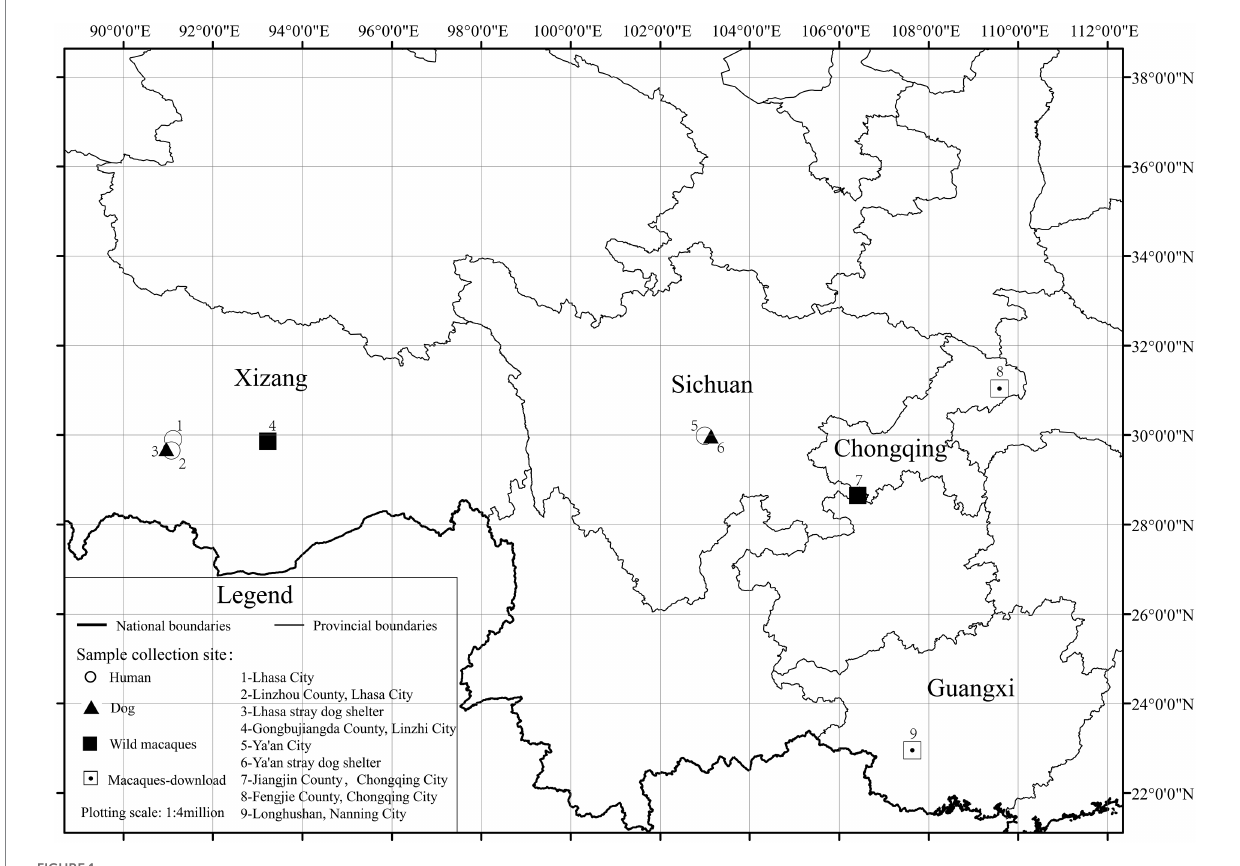
FIGURE 1 Sample collection